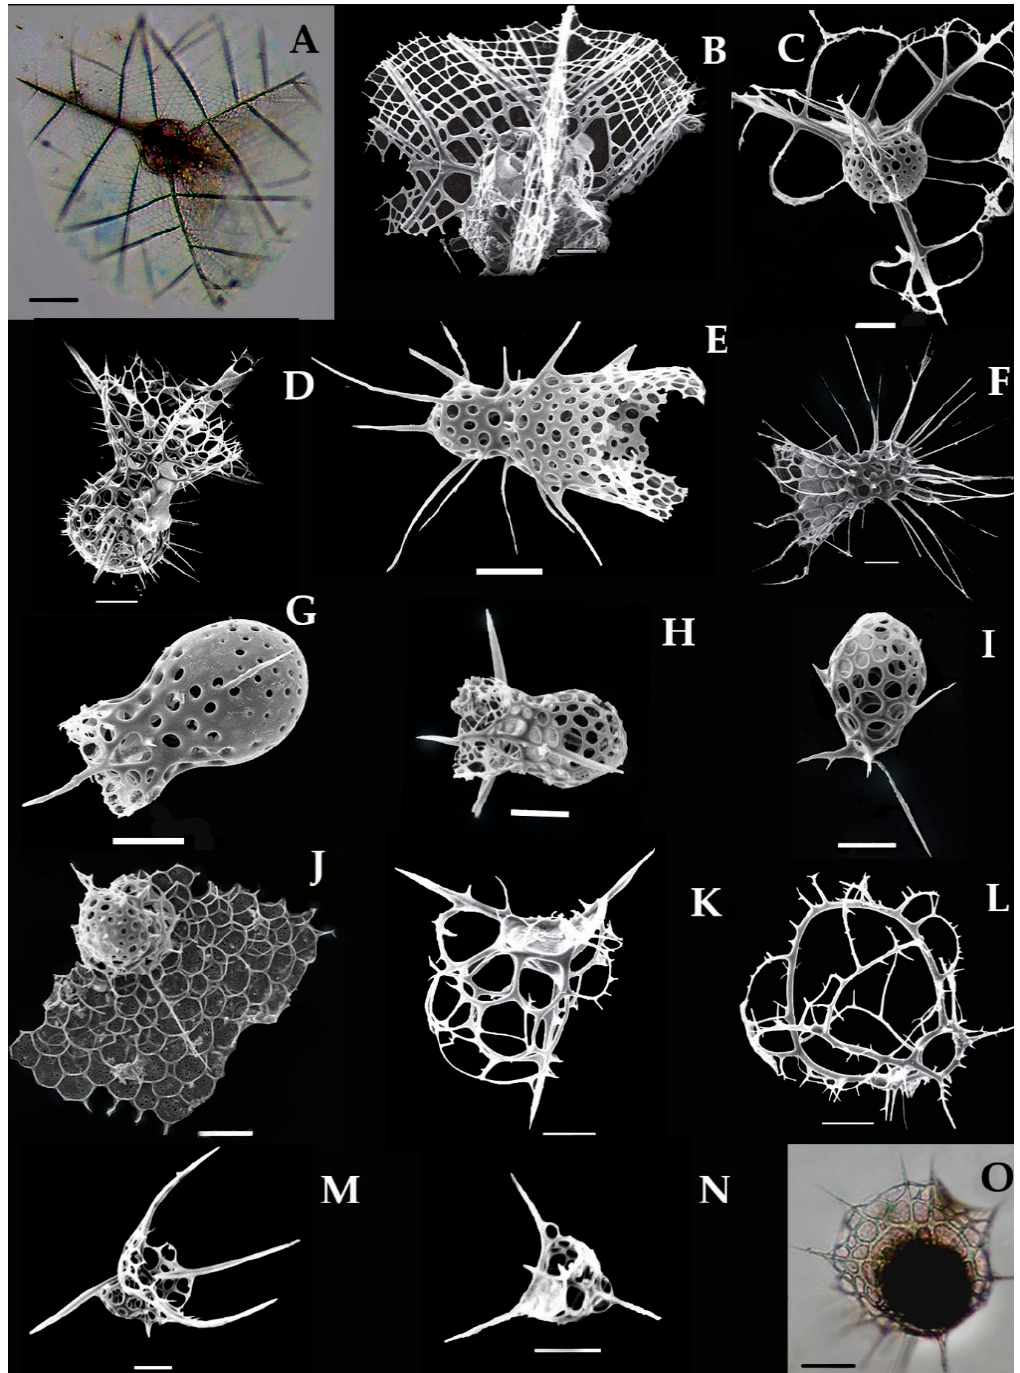
Figure 8. Light and scanning electron micrographs of Nassellarian species ( A – O ). These images were modified from Munir et al. [27]. ( A , B ) Callimitra emmae ( C ) Clathrocorys murrayi , ( D,H ) Lophophaena capito , ( E , F ) Lophophaena cylindrica , ( G ) Peromelissa phalacra, ( I ) Peridium spinipes , ( J ) Lampromitra schultzei, ( k ) Phormacantha hystrix , ( L ) Plectacantha trichoides , ( M ) Pseudodictyophimus gracilipes , ( N ) Cladoscenium ancoratum , ( O ) Tetraphormis dodecaster. Scale bars: LM: 10 µm and SEM: 10 µm, 20 µm.